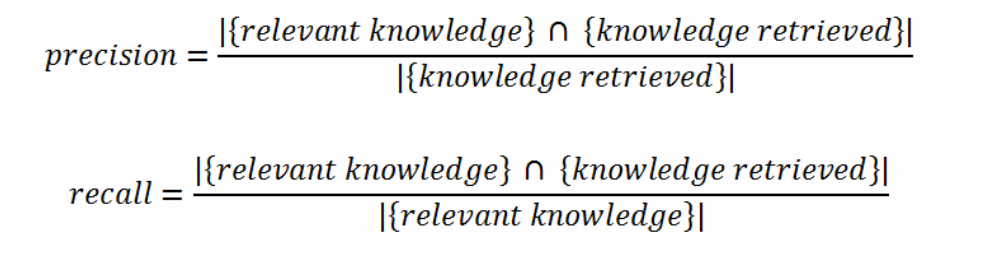
Figure 3. Precision and recall metrics.